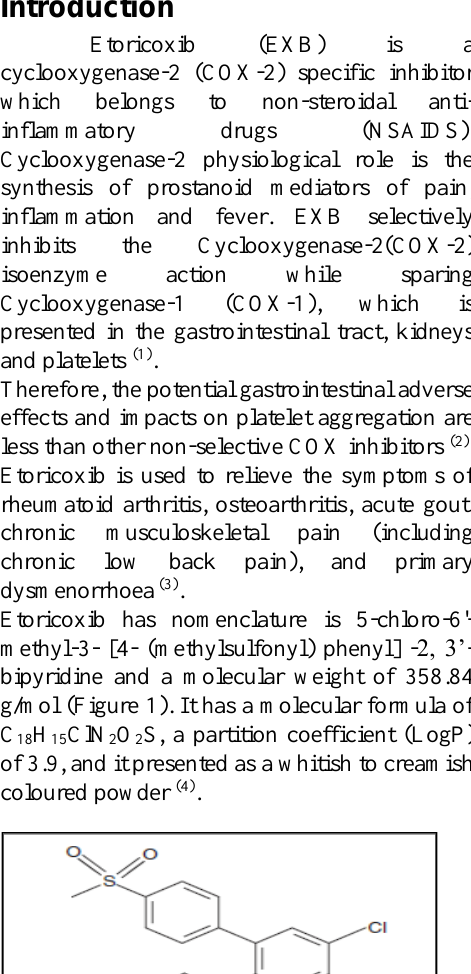
Etoricoxib is classified as a class II based on